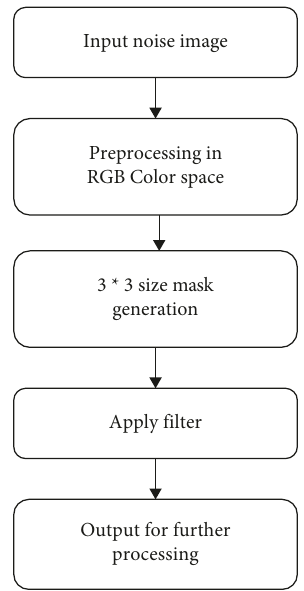
Figure 6: Structure of preprocessing